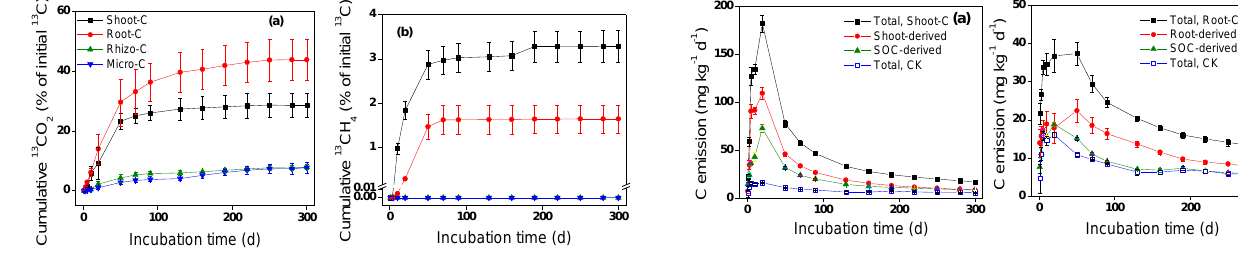
Figure 2. Cumulative 13 CO 2 (a) and 13 CH 4 (b) emissions over the 300-day incubation period. Values and error bars represent mean % of initial 13 C ± SE ( n = 4). Shoot-C, unlabelled paddy soil supplemented with 13 C-labelled shoot residue; root-C, unlabelled paddy soil supplemented with 13 C-labelled root residue; rhizo-C, paddy soil containing 13 C-labelled rhizodeposits; micro-C, paddy soil containing 13 C-labelled microbe-accumulated C.